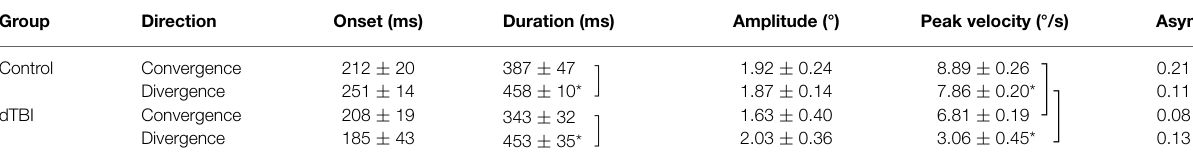
TABLE 3 | Oculomotor dynamics for vergence eye movements .